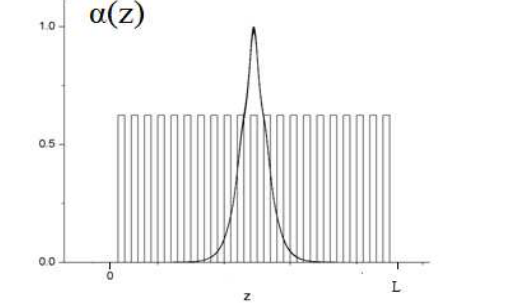
Figure 1. Spatial distribution of nonlinearity of medium and initial spatial distribution of optical intensity inside the